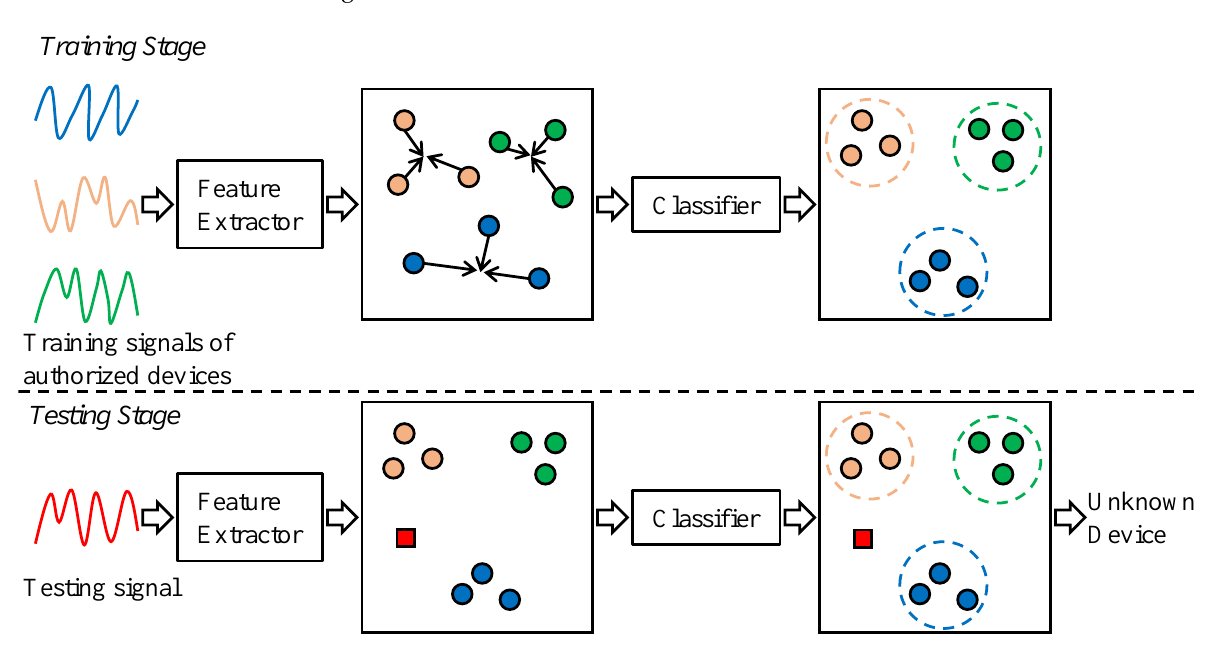
Figure 2. The open-set authentication of IoT